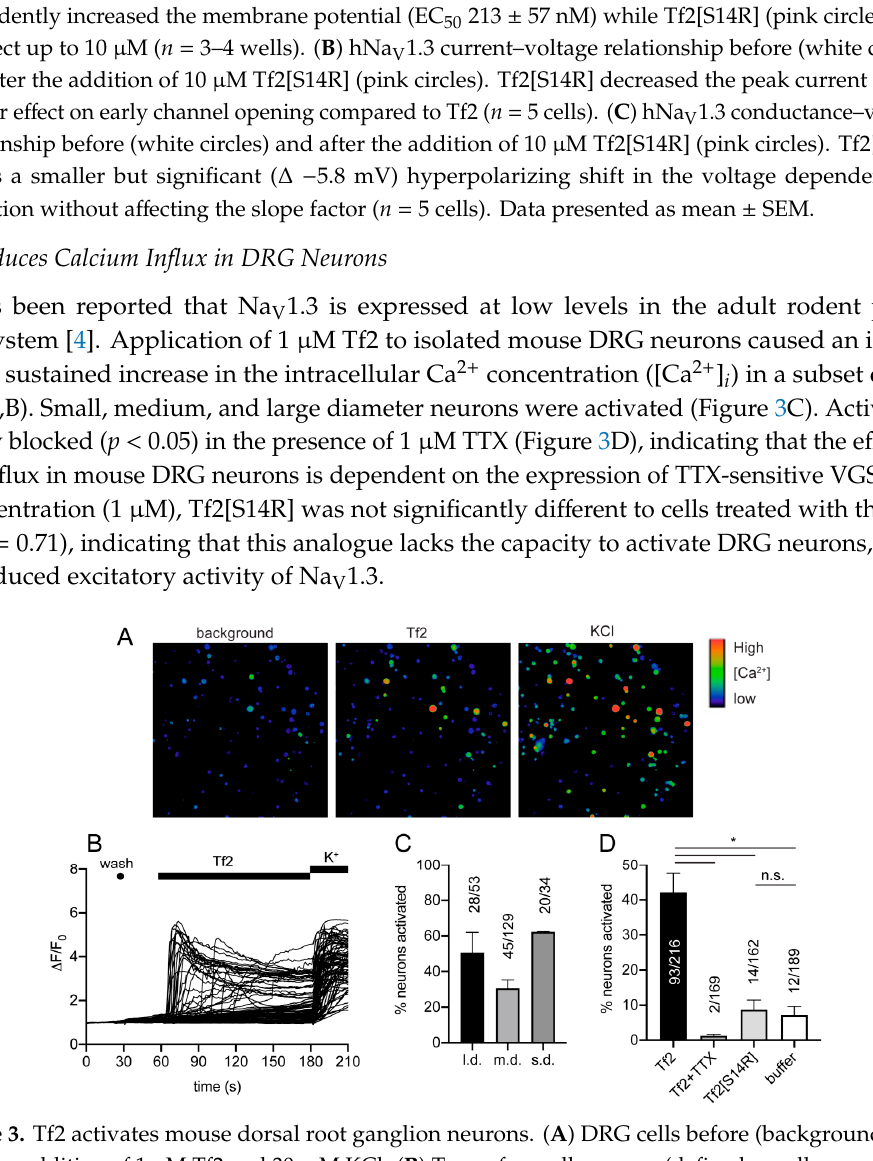
Figure 2. Tf2[S14R] loses excitatory activity at hNa V 1.3. ( A ) Comparative activity of Tf2 and Tf2[S14R] on hNa V 1.3 assessed using the FLIPR Tetra membrane potential assay. Tf2 (blue circles) concentration-